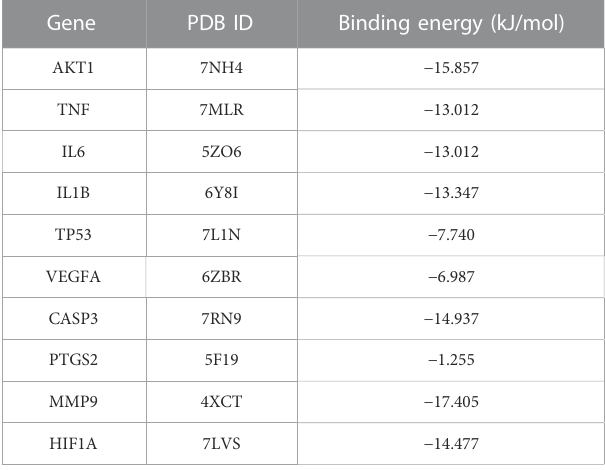
TABLE 2 Molecular docking results of Sanchi with hub